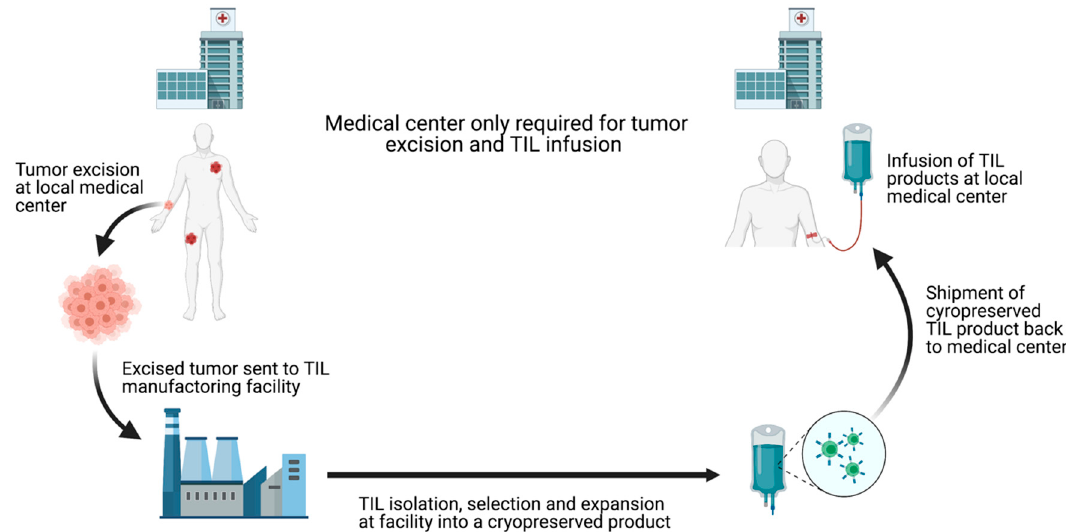
Figure 4. Schematic depiction of centralized TIL production chain. Commercialization of TIL production can increase TIL-ACT implantation by reducing the requirements for local medical centers. By outsourcing TIL production, treatment facilities only need to have the surgical and medical capacities to remove the tumor and treat potential infusion-associated adverse effects. TIL (tumor-infiltrating lymphocytes); ACT (adoptive cell therapy).